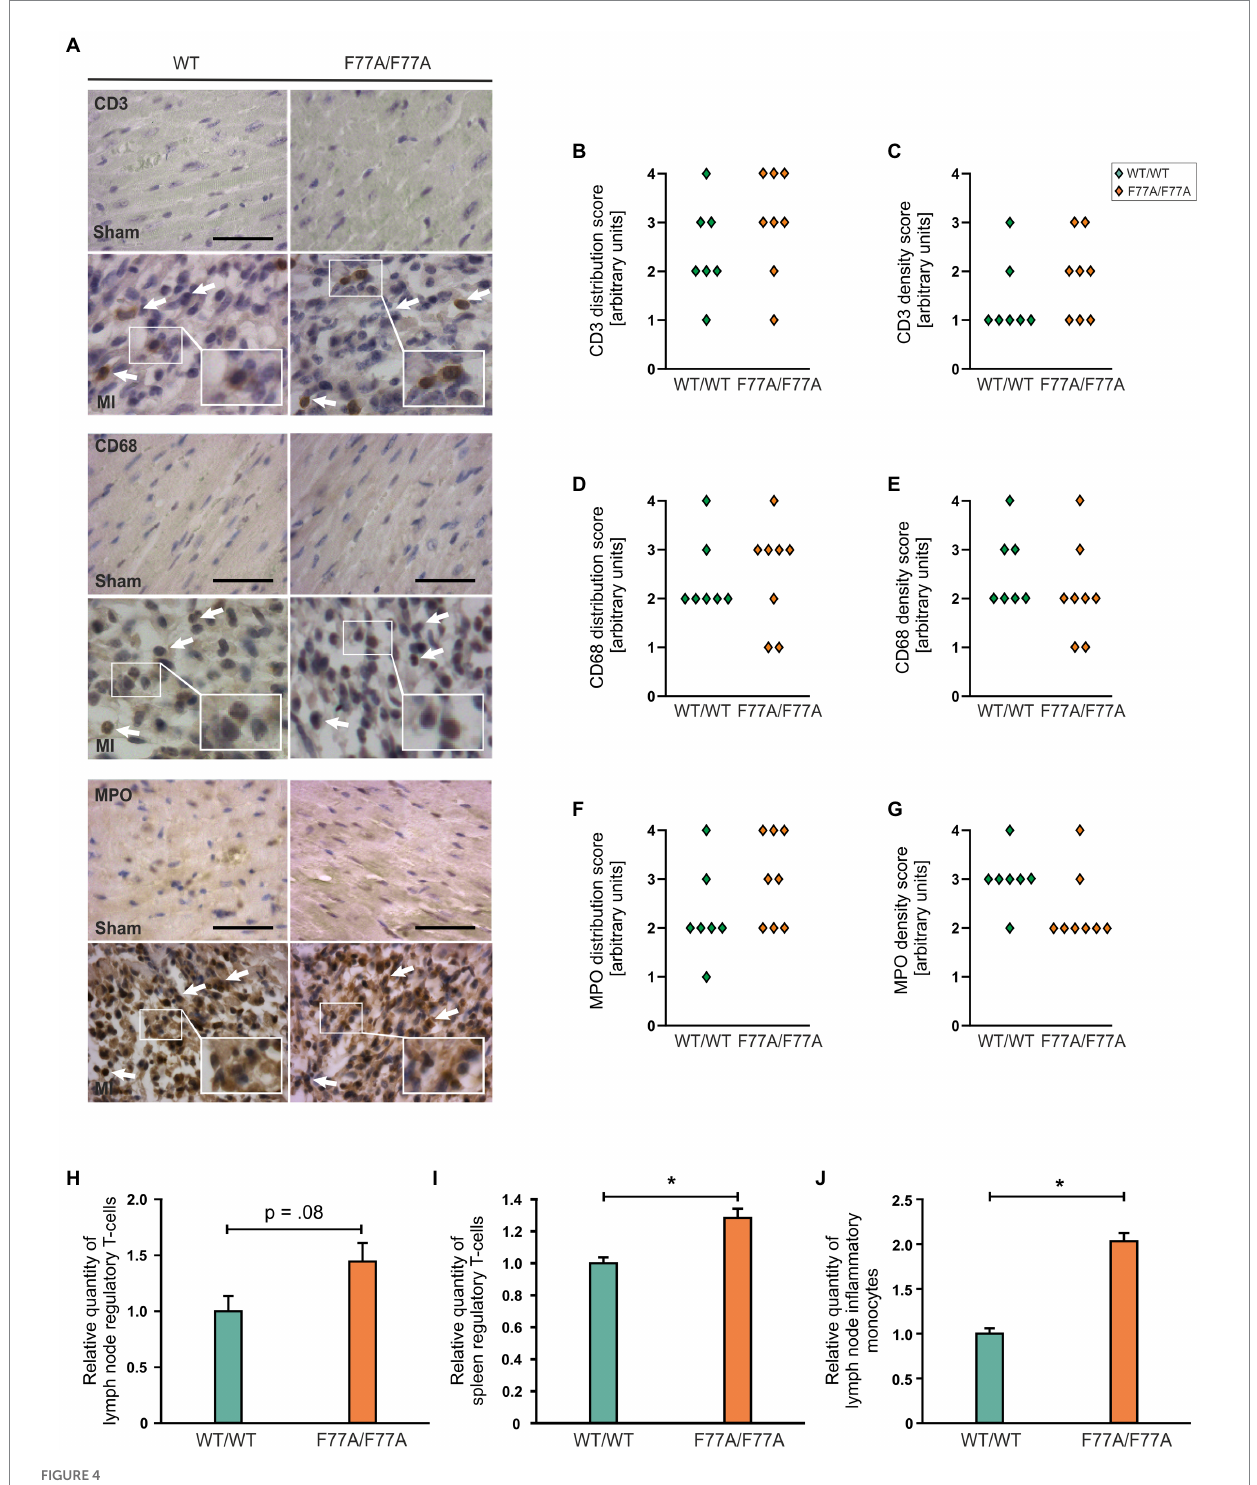
FIGURE 4 Recruitment of different immune cells in WT and STAT1 F77A/F77A mice. (A) Immunohistochemical staining of immune cell subsets in STAT1 F77A/F77A mice with antibodies against CD3 (upper panel), CD68 (middle panel), and myeloperoxidase (MPO) (lower panel) as markers for T cells, monocytes and neutrophil granulocytes, respectively, on day 3 following MI or sham operation. Representative LV wall micrographs of sham-operated animals (top) and mice subjected to LAD ligation (bottom) from the two genotypes (scale bar: 50 μm, WT/WT male n = 4, female n = 3; F77A/F77A male n = 5, female n = 3). Arrows mark positively stained cells expressing the indicated antigen. Arbitrary quantification of the (B) distribution of CD3-positive cells and their (C) density over the ventricular wall and septum. Quantification of the distribution (D , F) and density (E , G) of CD68-positive (D , E) and MPO- positive cells (F , G) (WT/WT male n = 4, female n = 3; F77A/F77A male n = 5, female n = 3). (H–J) Analysis of the relative numbers of regulatory T cells (H , I) and inflammatory monocytes (J) in lymph nodes (H , J) and spleen (I) of 9-week-old females from the STAT1 F77A/F77A mouse line as compared to WT controls. Asterisks indicate statistically significant differences (value of p ≤ 0.05; t-